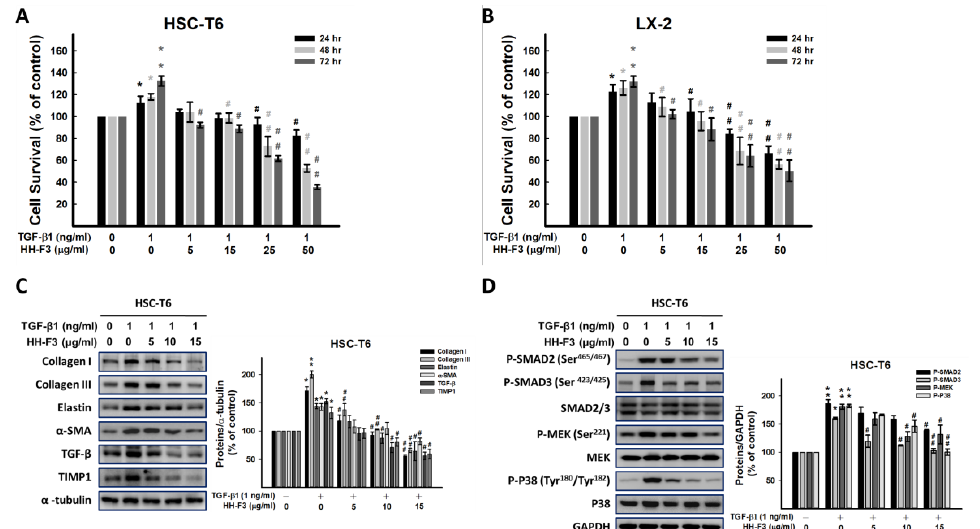
Figure 3. HH-F3 inhibits TGF-β1-induced cell proliferation via TGF-β pathway suppression. ( A ) HSC-T6 and ( B ) LX-2 cell viability was assayed in the presence of HH-F3 and transforming growth factor beta (TGF-β1, 1 ng/mL) by SRB assay. ( C ) HSC-T6 cells were preincubated with 1 ng/mL of TGF-β1 for 1 h and then cotreated with HH-F3 at different concentrations. The dose-dependent inhibitory effect on collagen type I, collagen type III, elastin, and α-SMA expression was determined by Western blot analysis. Data represent at least three independent experiments. ( D ) HSC-T6 cells were pretreated with 1 ng/mL of TGF-β for 1 h and then cotreated with various concentrations of HH-F3 for 24 h. HH-F3 blocked TGF-β1 (1 ng/mL)-induced SMAD2/3, MEK, and P38 phosphorylation. Data represent at least three independent experiments. * p < 0.05, ** p < 0.01 compared to the control group; # P < 0.05 compared to the TGF-β1-induced group.